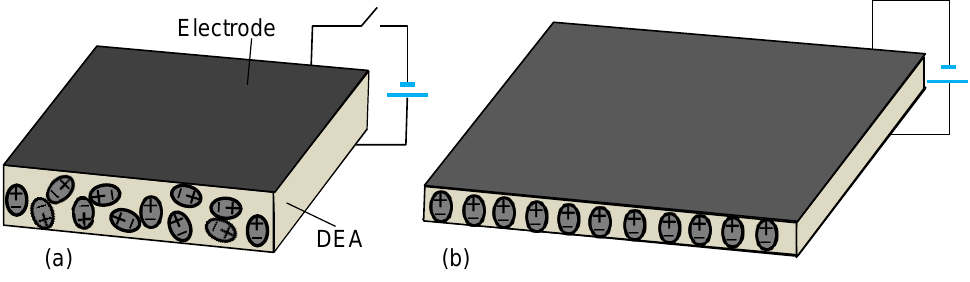
Figure 1. Working principle of a DEA film: ( a ) voltage-off state and ( b ) voltage-on state.